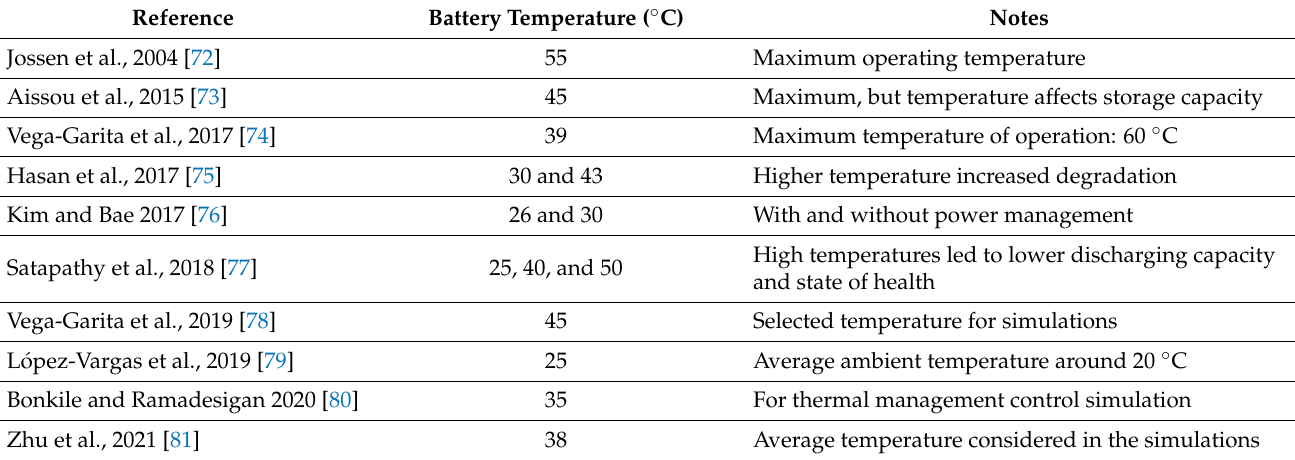
Table 6. Literature review of the values for PVB selected